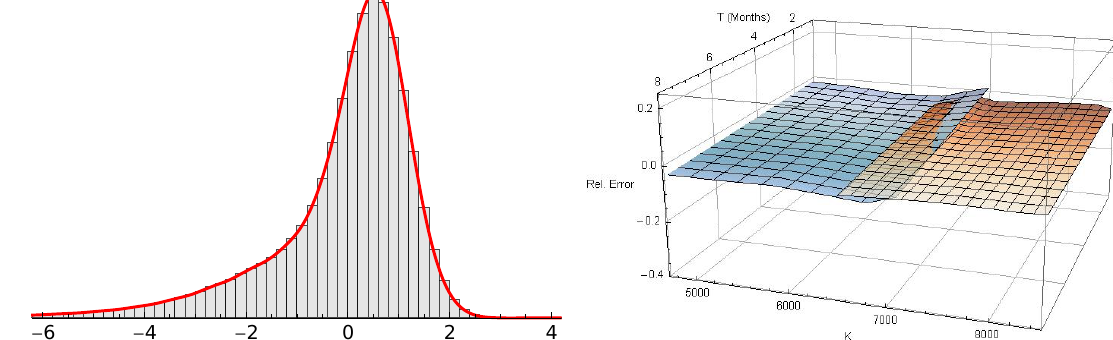
Figure 6. One million draws from the multinomial density approximation for T = 1 ( left )—capped option valuation with 100,000 draws from N ( 0,2 ) importance distribution ( right